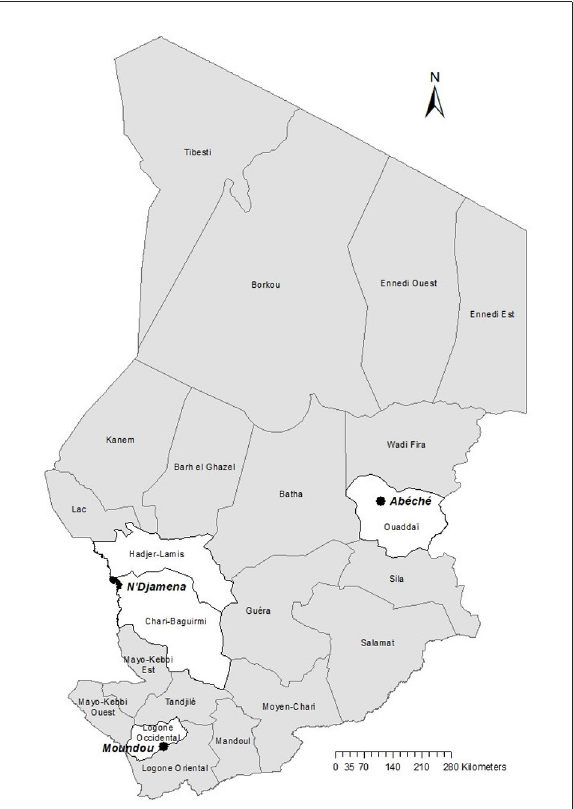
FIGURE1 Map of Chad showing the provinces in which the GAVI-project was implemented.